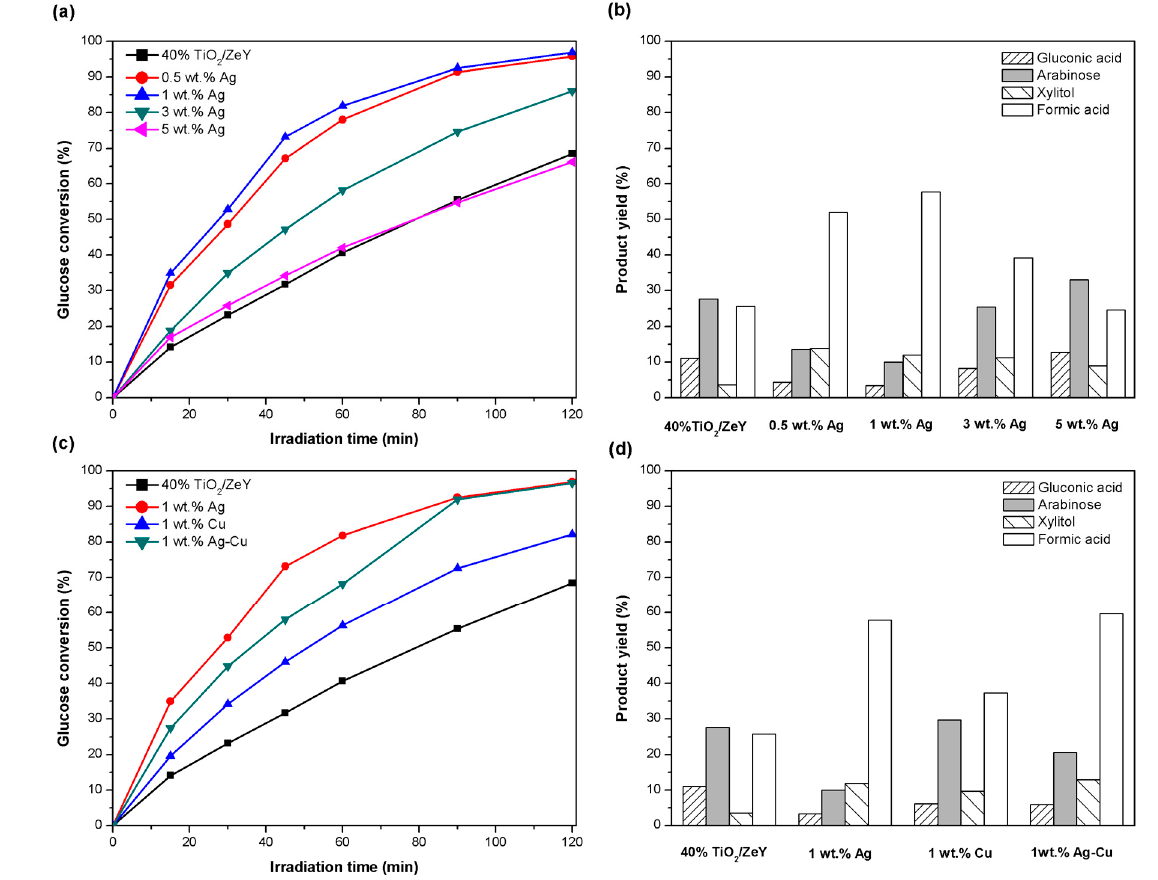
Figure 7. Photocatalytic conversion of glucose of Ag-TiO 2 (40%) / ZeY, Cu-TiO 2 (40%) / ZeY, and Ag-Cu-TiO 2 (40%) / ZeY under UV irradiation for 120 min [( a ) and ( c )]. Product yield of main products under UV irradiation at 120 min [( b ) and ( d )].